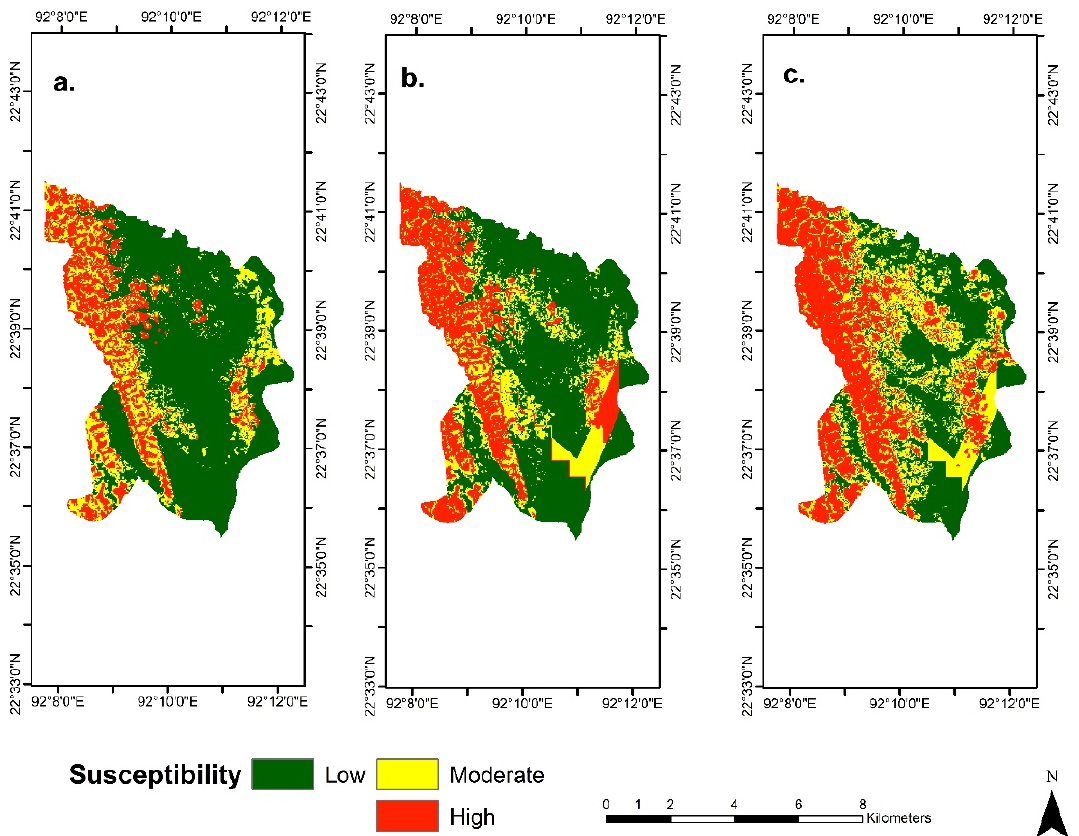
Figure 5. Landslide susceptibility maps based on random forest: ( a ) existing land use/land cover, ( b ) proposed land use/land cover, ( c ) simulated land use/land cover for 2028 .